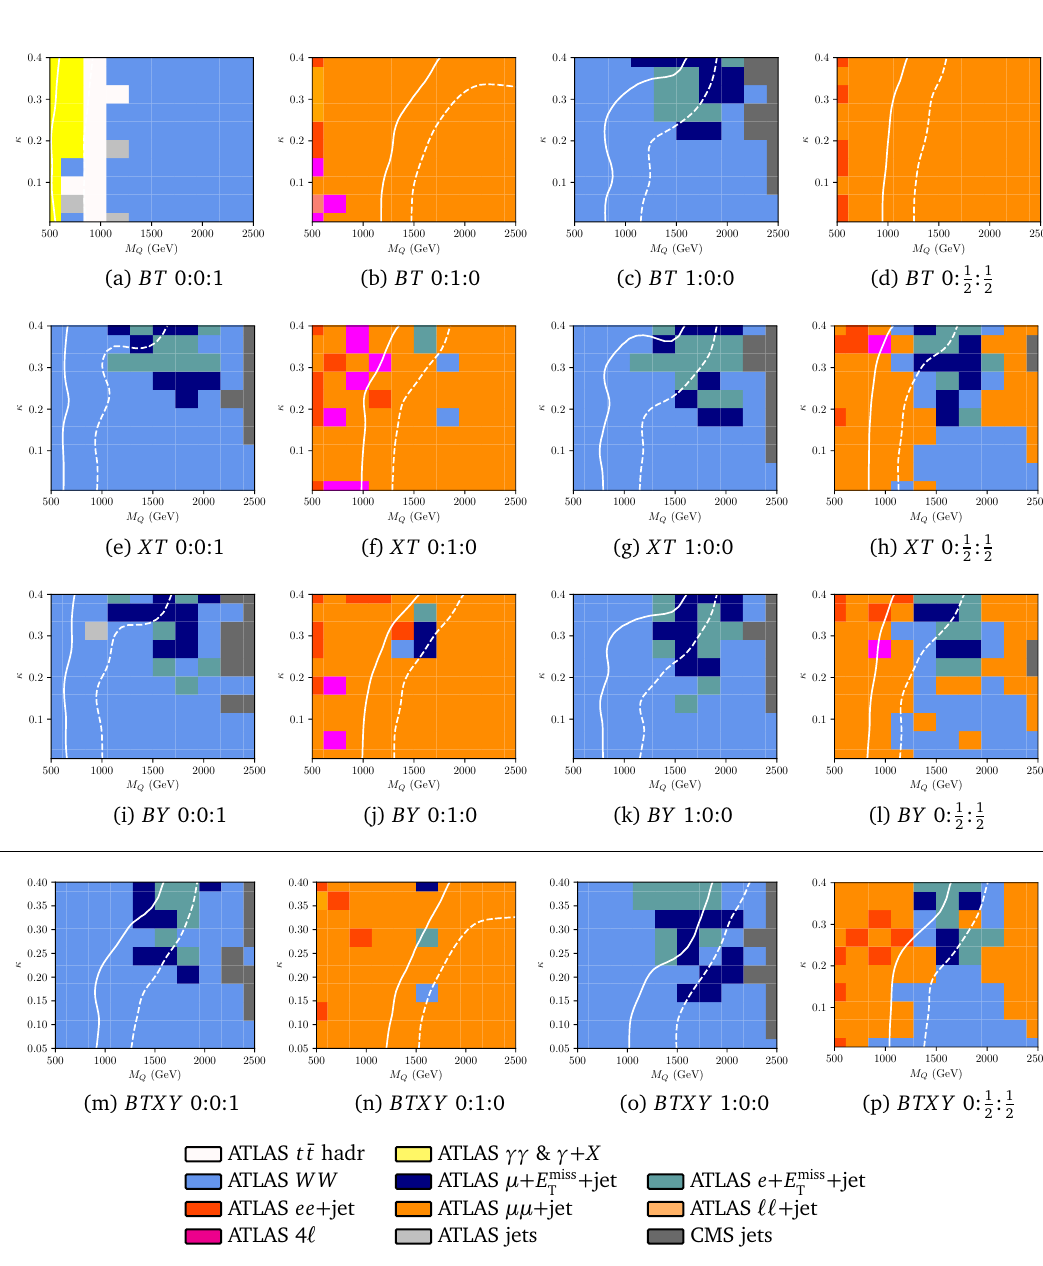
Figure 15: Sensitivity of LHC measurements to VLQ doublet production in the κ vs VLQ mass plane, where κ is the coupling to second-generation SM quarks. All VLQ masses are set to be degenerate. The multiplets are given as rows: (a)–(d)( B , T ) doublet, (e)–(h)( X , T ) doublet, (i)–(l)( B , Y ) doublet, and for comparison to the main text, the (m)–(o)( B , T , X , Y ) quadruplet. The VLQ branching fractions to W : Z : H are arranged in columns of 0:0:1, 0:1:0, 1:0:0, and 0: 1 case is considered for doublets instead of 1